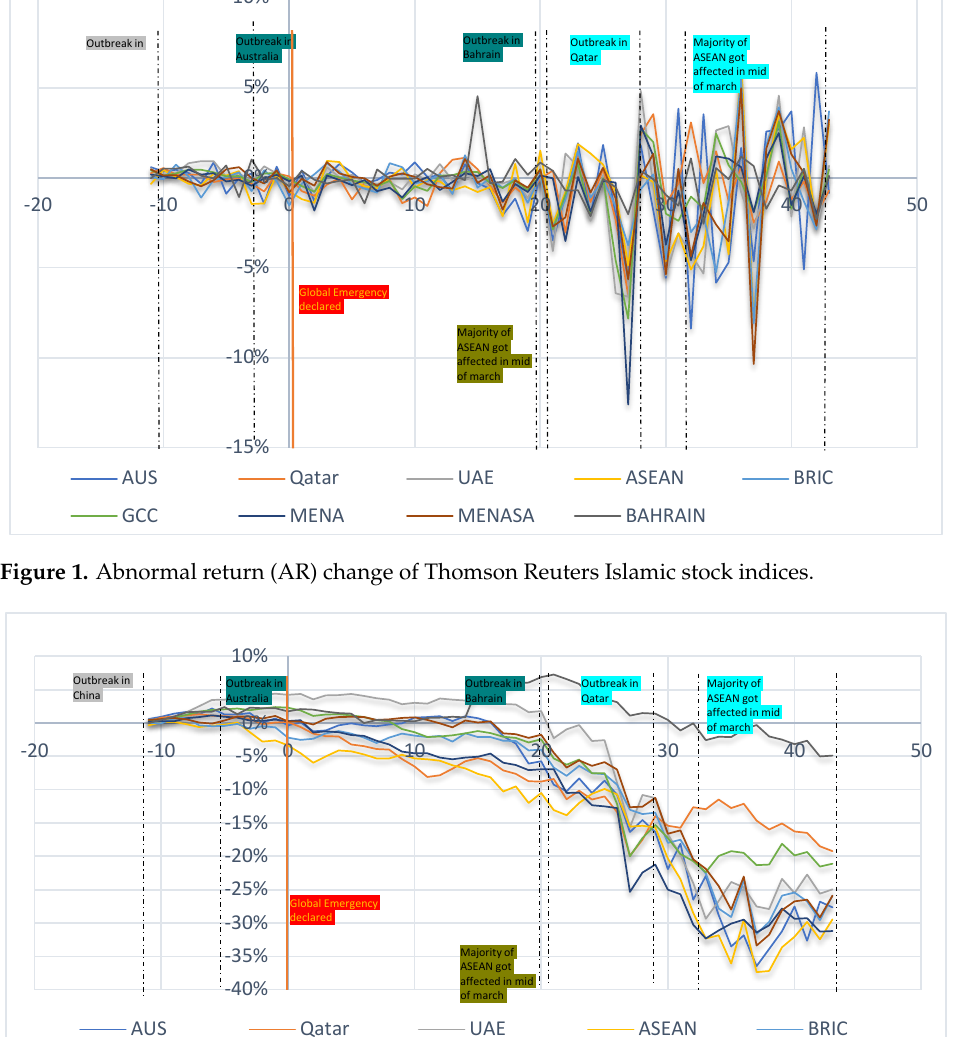
In Bahrain, there were only 569 total cases of COVID-19 by the end of March. Furthermore, the Bahrain stock index was the least affected by the COVID-19 pandemic.